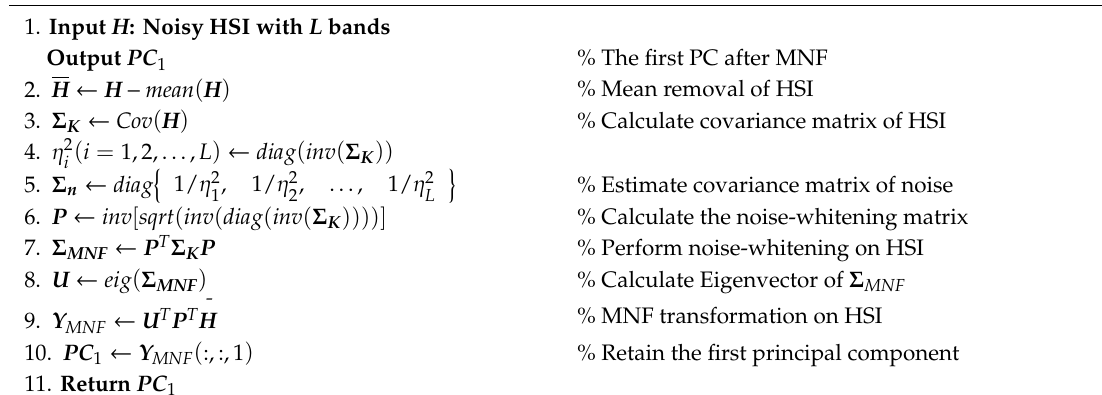
Algorithm 1 Minimum Noise Fraction (MNF)-Based Dimensionality Reduction of a Hyperspectral Image